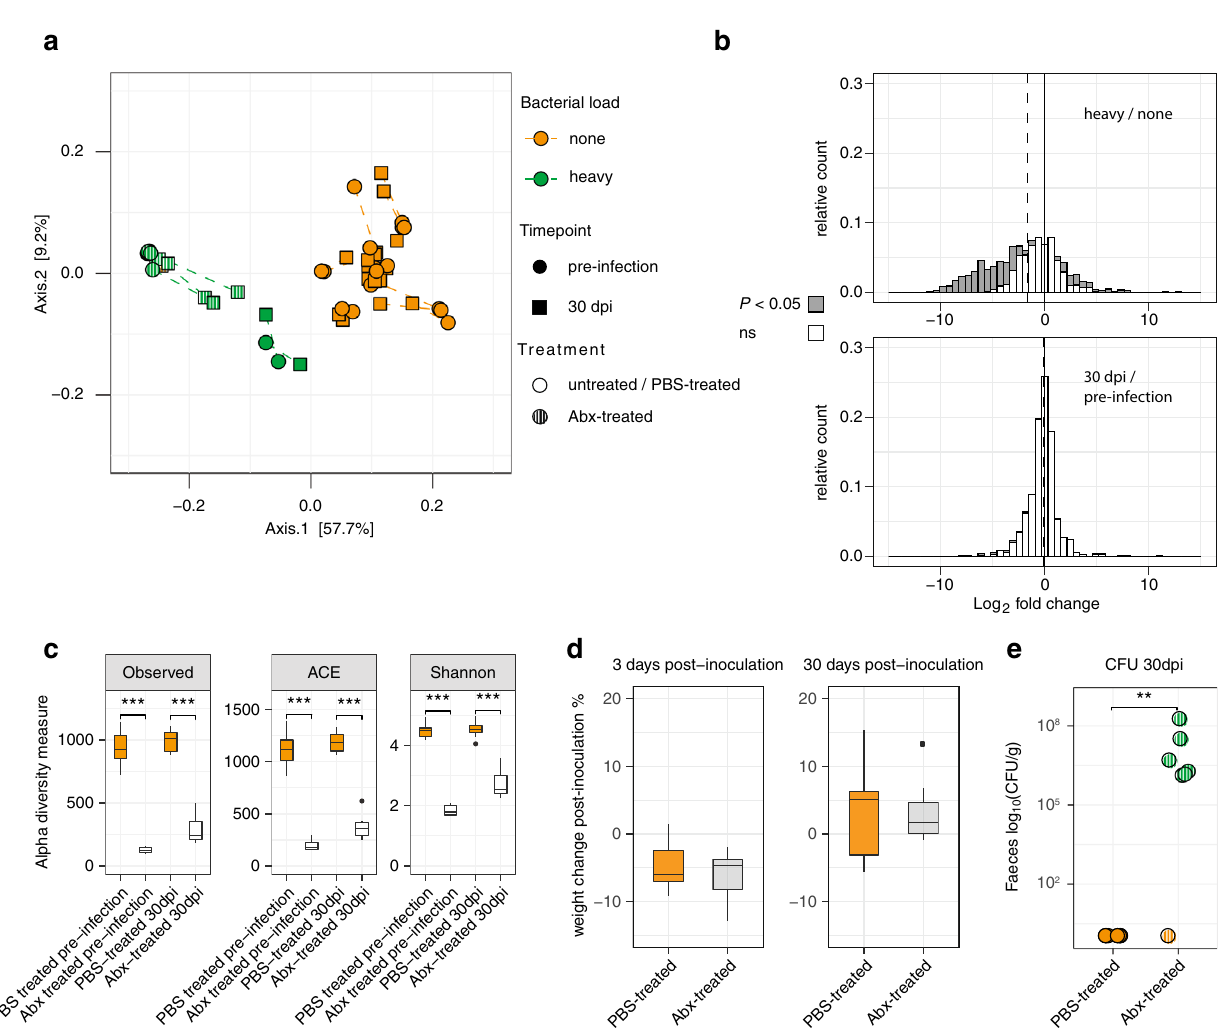
Fig. 8 Lm faecal carriage depends on the microbiota. a Comparison of microbiota pre-inoculation and 30-days post-inoculation. β -diversity of mice microbiomes using MDS and Bray – Curtis distance. The colour indicates the carriage group (<100 CFU/g: none, >10 6 CFU/g: heavy), the shape of the timepoint (round: Pre-inoculation, square: 30-days post-inoculation) and opacity of the treatment (plain: untreated or PBS-treated, striped: antibiotic treated) b Distribution of fold change determined by DESeq2 of OTUs between heavy and non-carriers (top) and pre- and post-infection (bottom). Dark bars indicate signi fi cantly differently present OTUs identi fi ed by DESeq2 ( P < 0.05 after Benjamini – Hochberg correction). The dashed bar indicates the median of the respective distribution. c Comparison of α -diversity, measured by observed species (left), abundance-based coverage estimates (middle) and Shannon index (right) between antibiotic- and PBS-treated mice 4 weeks after antibiotic treatment/before inoculation and 4 weeks after Lm inoculation. ( n Abx-treated = 7, n PBS-treated = 9, PBS-treated vs. Abx-treated pre-infection P = 0.00017, 30dpi P = 0.00017). d Body weight change of mice at 3 days post-inoculation and 30-days post-inoculation according to their treatment group (n PBS-treated = 9, n Abx-treated = 7, PBS-treated vs. Abx-treated 3 dpi: P = 0.76, 30dpi: P = 0.84). e CFU/g of the stool of female mice 30 days after an iv challenge with Lm at 5 × 10 3 CFU. Mice were either treated with antibiotics or PBS 4 weeks prior to inoculation. Statistical comparison performed with two-sided Wilcoxon rank-sum test (PBS-treated vs. Abx-treated: P = 0.0013). The statistical comparison was performed with a two-sided Wilcoxon rank-sum test. For boxplots, the hinges represent the fi rst and third quartile of the distribution. The whiskers extend from the hinge to the largest or smallest value no further than 1.5 x IQR from the respective hinge (where IQR is the inter-quartile range or distance between the fi rst and third quartiles). Points beyond this limit are